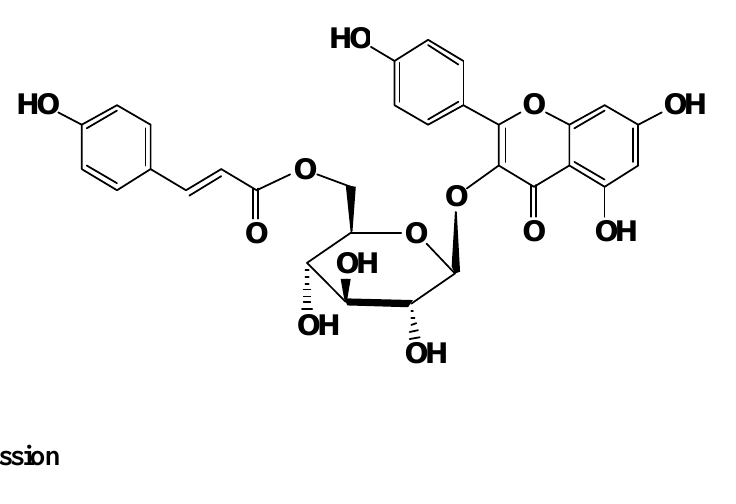
Figure 1. The structure of trans